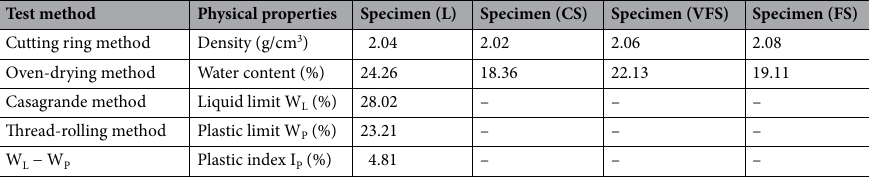
Table 1. Physical properties of four type soil samples and test